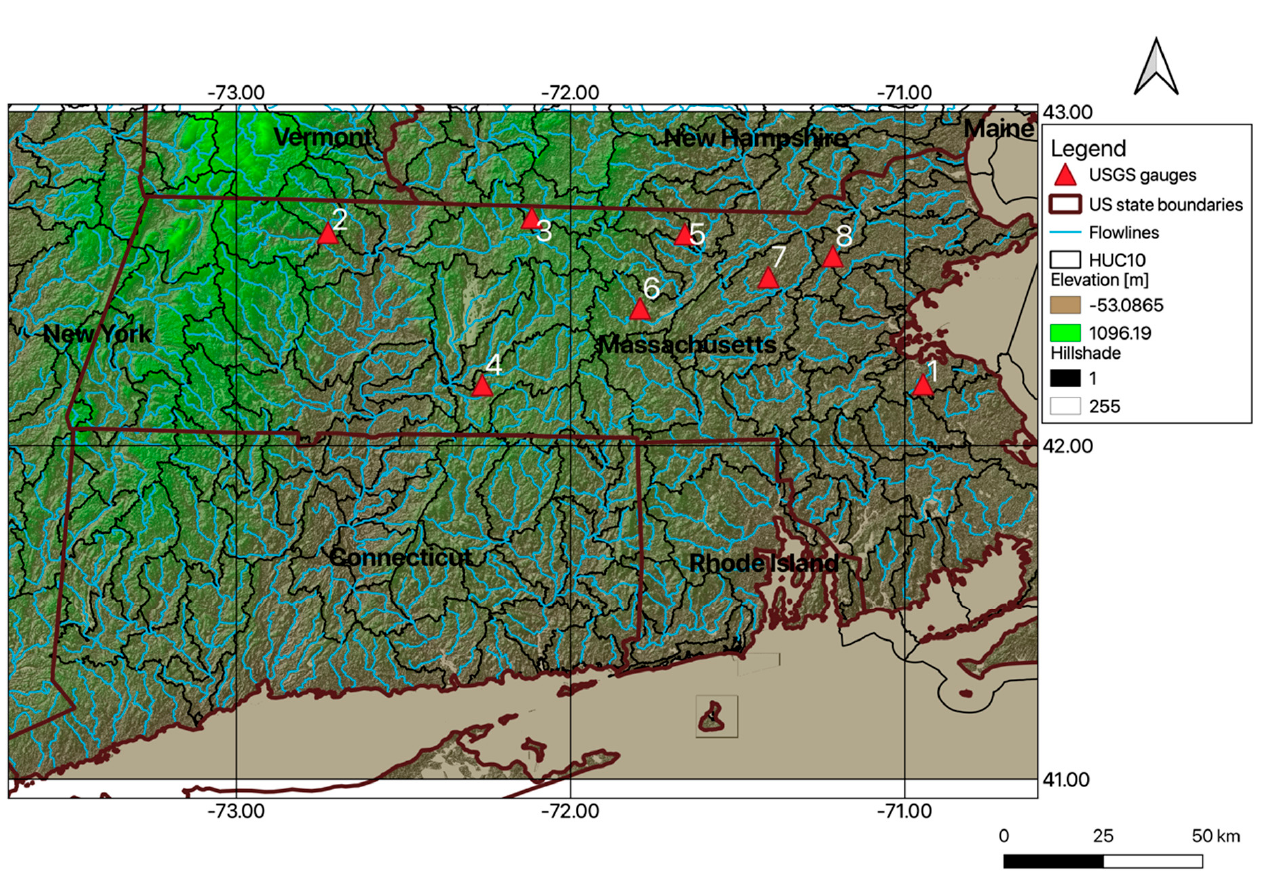
Figure 1. Study watersheds selected in the NEUS.